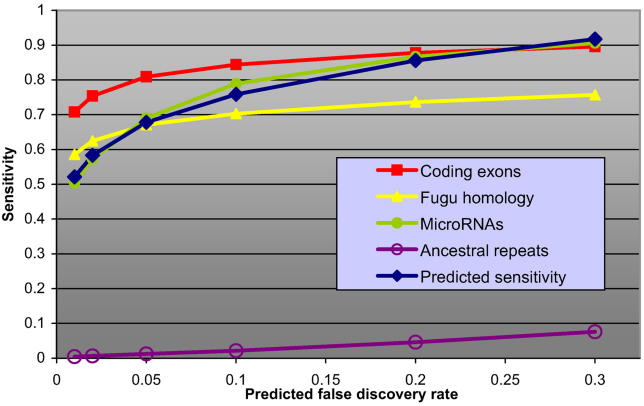
Experimental and Predicted Sensitivity versus Predicted FDRAxes show predicted proportion of neutral nucleotides (horizontal) and proportion of identified nucleotides among mouse-aligning nucleotides within annotation class (vertical). Red, yellow, and green curves show partial sensitivity to (known or likely) functional DNA, with the predicted sensitivity to DNA under indel-purifying selection (blue curve) following their general trend. For a fair comparison, the partial sensitivities were computed relative to the material common to human, mouse, and dog. The purple curve charts the sensitivity for neutrally evolving ARs, for comparison. Note that the false positive fraction (relative to mouse-aligning neutral elements) is considerably lower than the predicted FDR (relative to the identified set). Converting to the false positive fraction, we calculate the area under the resulting receiver-operating-characteristic curve to be high at 0.93, indicative of the method's discriminatory power.